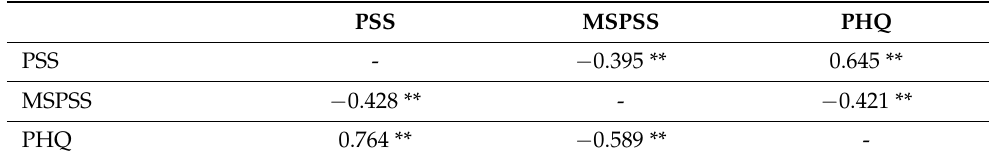
Figure 2. Clustered bar graphs illustrating dots, means, and confidence intervals for each group using a bar chart with error bars. BPDS = borderline personality disorder symptoms. Table 2. Comparison of the correlation coefficients between low levels of BPDS and high levels of